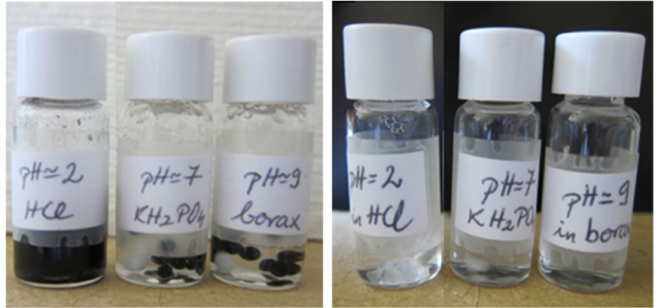
Figure 4. MWNT–DNA–CTAB and PEG–DNA–CTAB gel particles in different pH solution after one